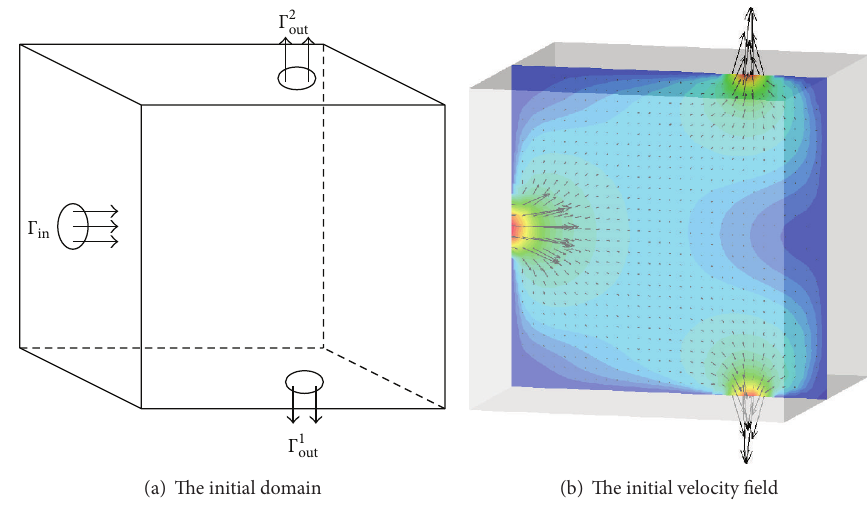
Figure 2: The initial domain and Figureelocity field.